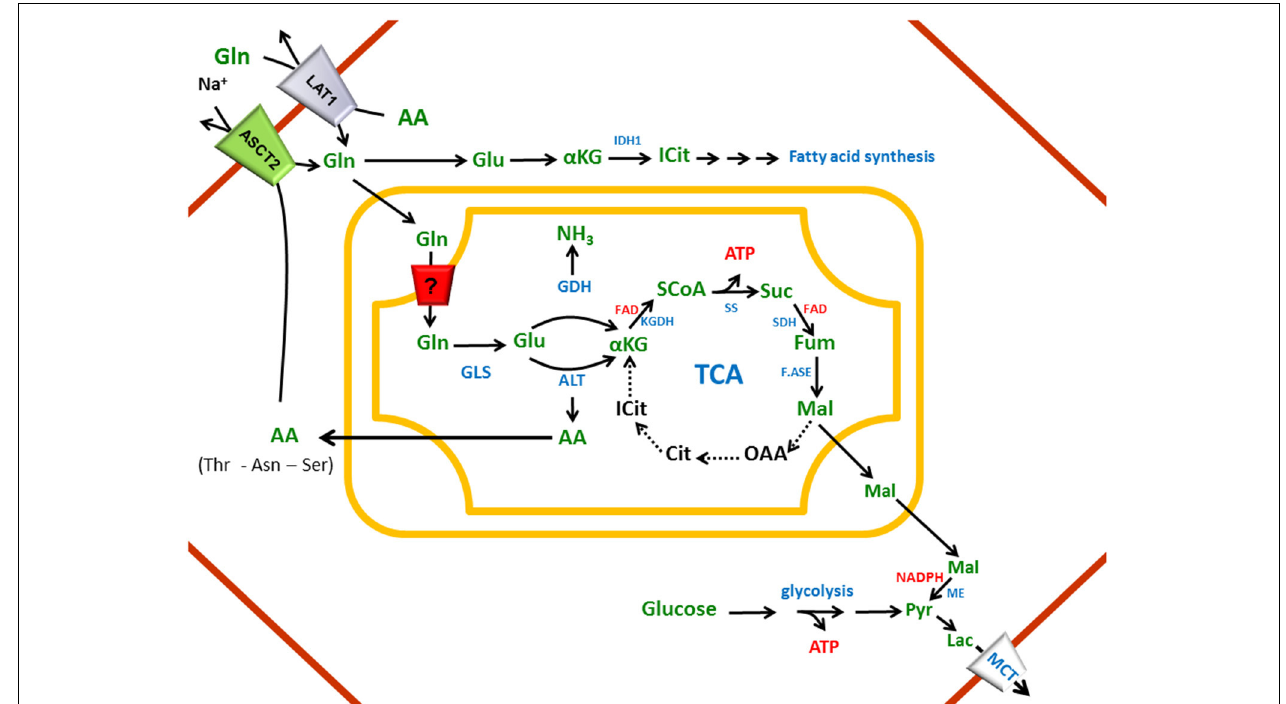
FIGURE 8 | Network of transporters involved in cancer metabolic switch. In cell membrane (red), ASCT2 and LAT1: glutamine plasma membrane transporters; MCT: Monocarboxylate Transporter. In cytosol (upper part of the figure), Gln: glutamine, Glu: glutamate, α KG: α Ketoglutarate, ICIT: isocitrate, IDH1: Isocitrate dehydrognase 1 and simplification of reactions to fatty acid synthesis; (lower part of the